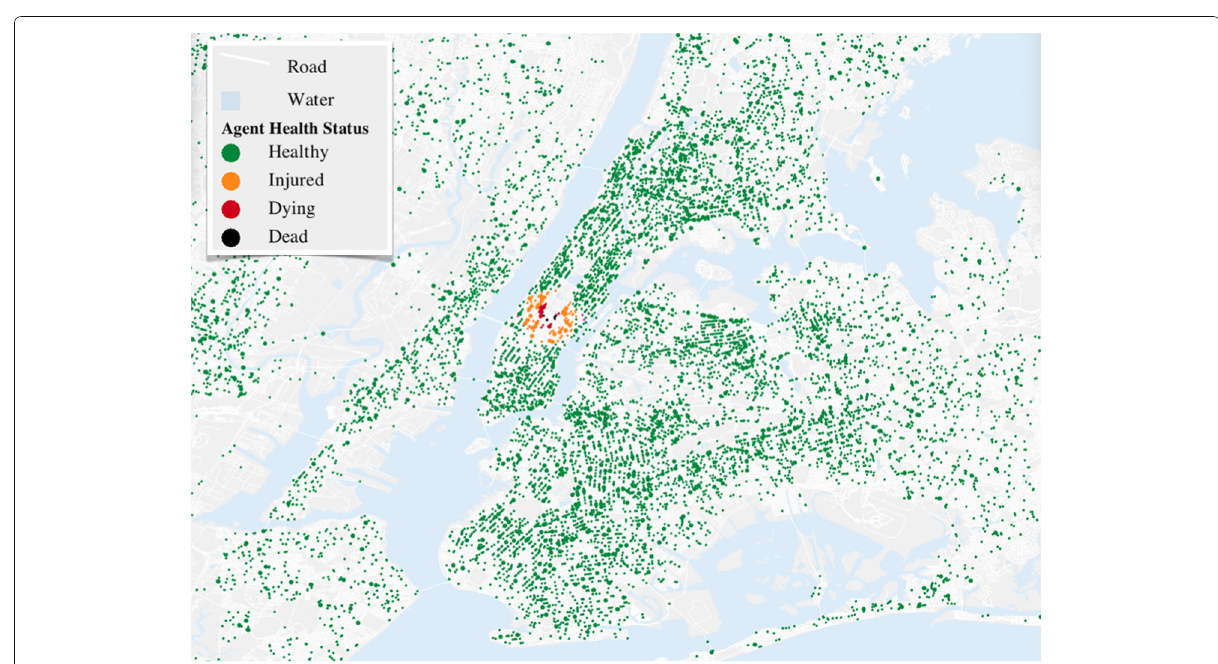
Fig. 13 Agents’ Health Status After 1 Minute of the Disaster Event